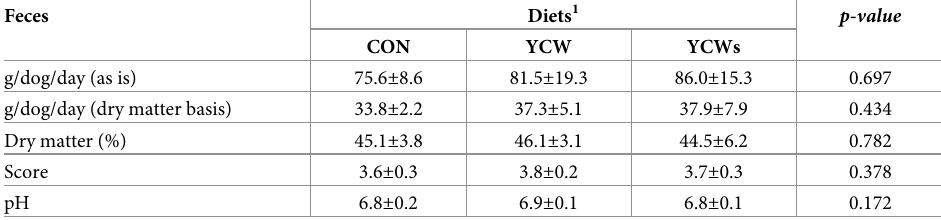
Table 4. Feces production and characteristics of dogs fed diets with the addition of different yeast cell wall prepa- rations (mean and standard error of the mean). Feces Diets 1